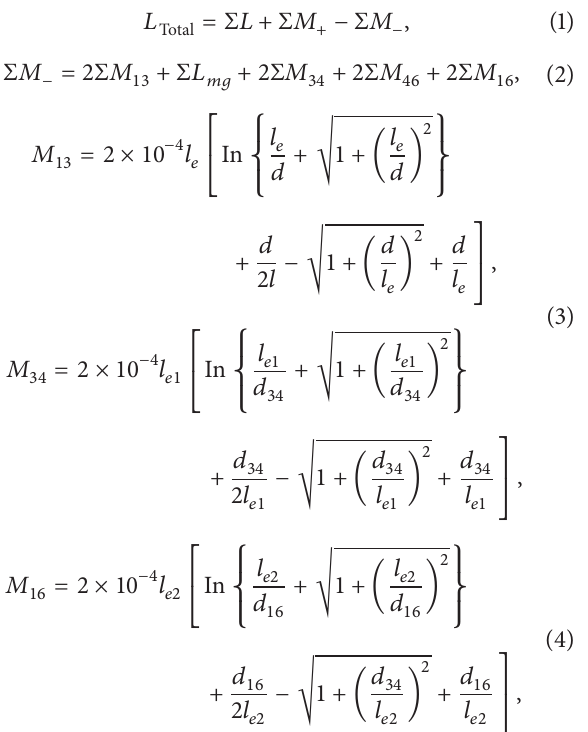
Figure 4. The lengthening of the effective patch’s surface current paths is due to the additional downward paths in the added rims, which is different from that of the mean- dered designs; a relatively very small perturbation on